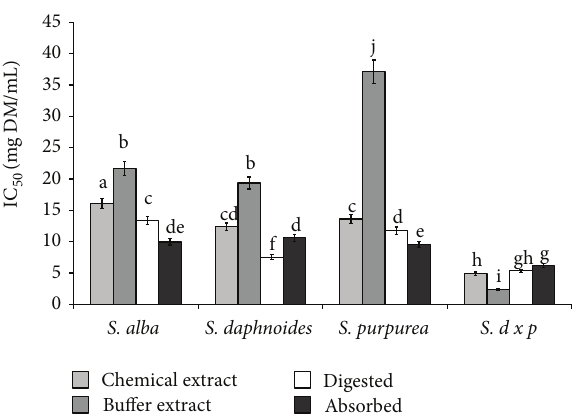
Figure 2: Effect of extraction system on antiradical activity of phytochemicals from bark of different Salix genotype. Bars (means) followed by the different letters differ significantly (Tukey-test, 𝑃 < 0.05 ).